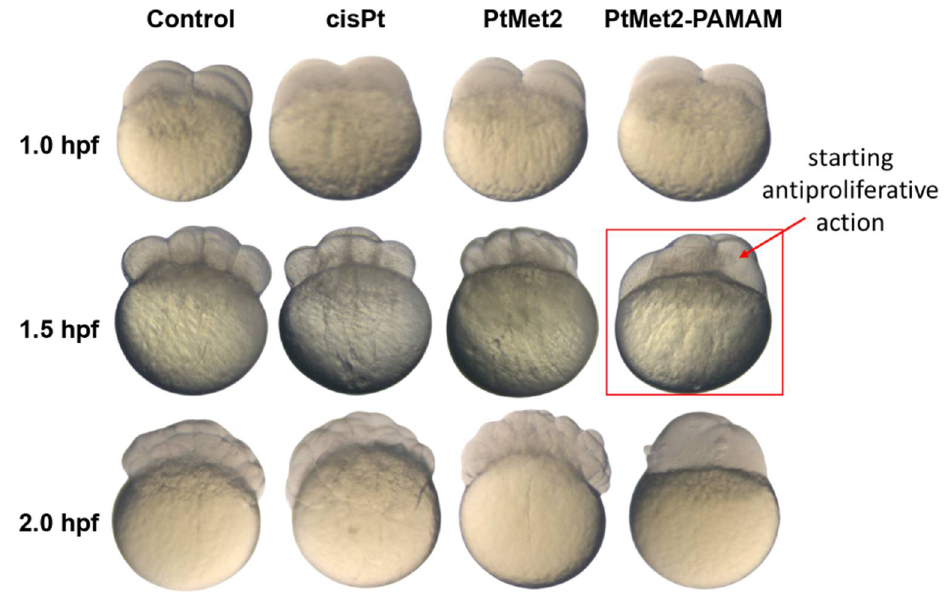
Figure 3. Effect of PtMet2, PtMet2–PAMAM, and cisplatin on cell division in the zebrafish embryo. Zebrafish eggs after 1.0, 1.5, and 2.0 h of exposure to the tested compounds; n = 10. hpf: hours post fertilization; hpt: hours post treatment.